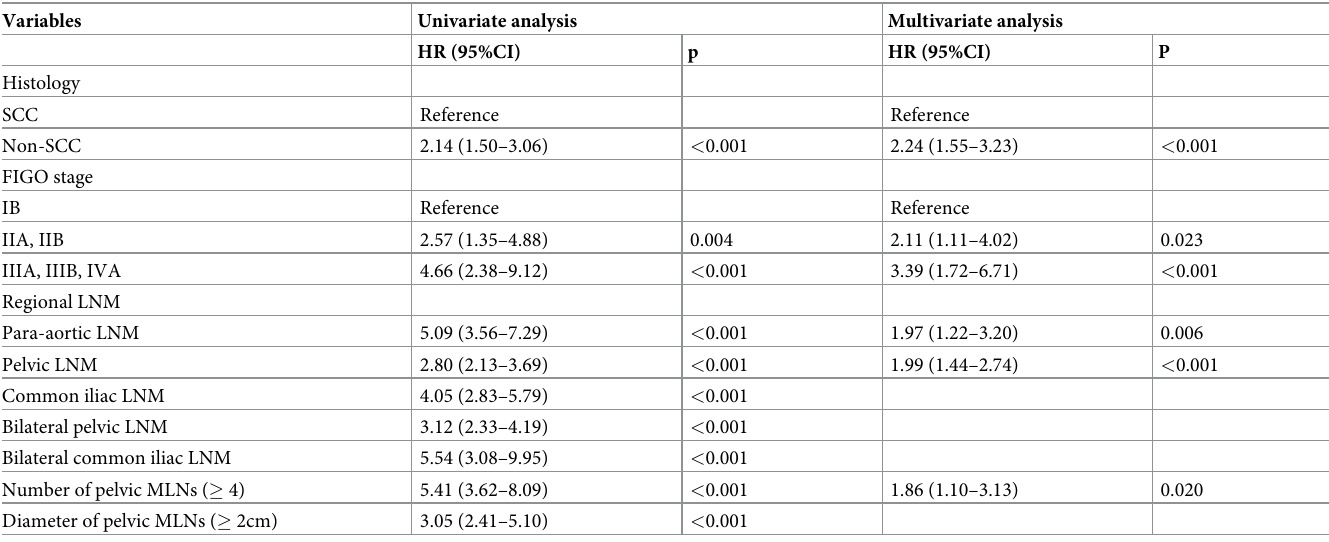
Table 3. Univariate and multivariate analysis for disease-free survival.